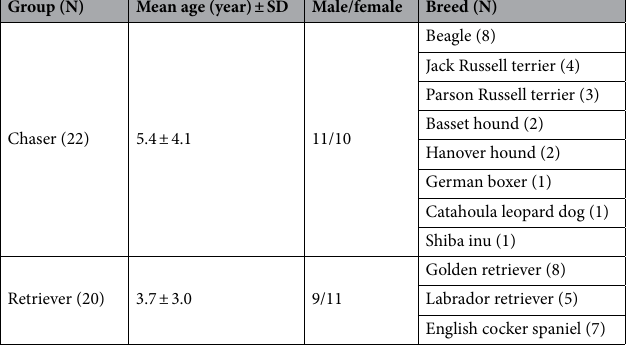
Table 1. Details of subjects involved in the final analyses. For more details, see Supplementary Data S1.